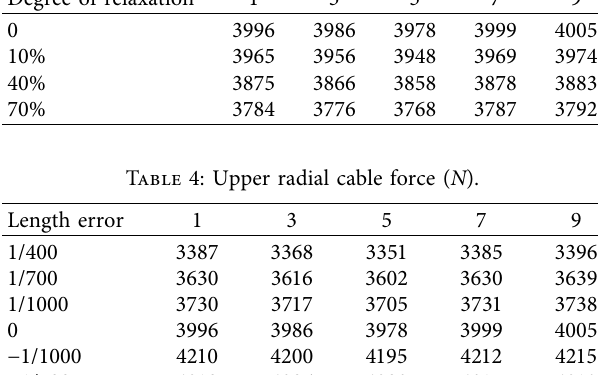
Figure 9: Cable monitoring point. Table 6: Comparison of actual and predicted structural risk